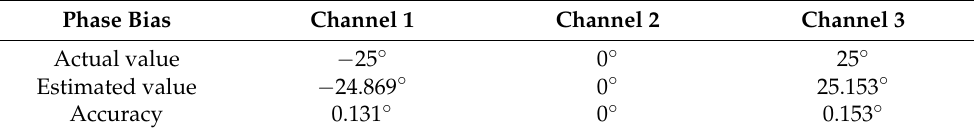
Figure 5. ( a ) Azimuth profile with phase bias. ( b ) Azimuth profile after calibration.